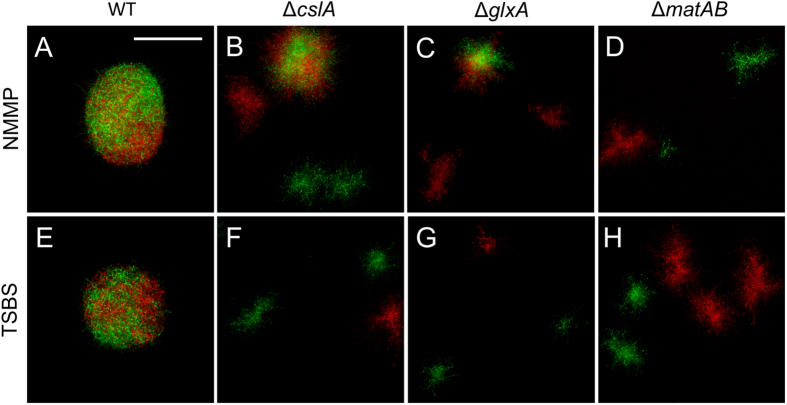
Aggregation depends on glycan synthases.Microscopy images of particles obtained 24 h after mixing spores of red- or green-fluorescent derivatives of the wild-type (WT), cslA, glxA or matAB mutant strains. Note that the majority of particles only have either green or red fluorescence in the absence of cslA, glxA, or matAB in both NMMP (top) and TSBS (bottom). Scale bar represents 100 μm (A,E) or 200 μm (B–D, F–H).